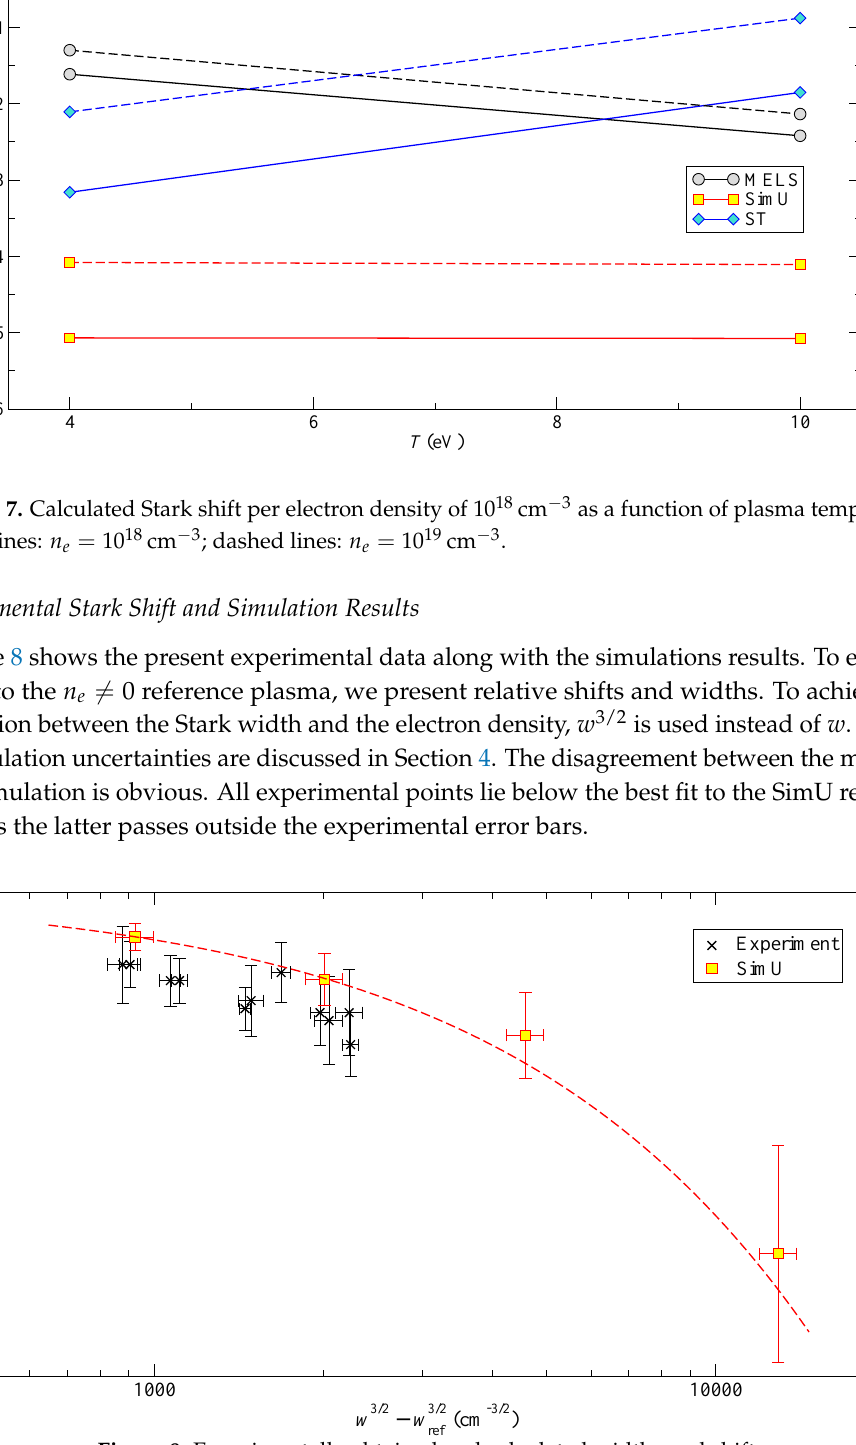
Figure 8. Experimentally obtained and calculated widths and